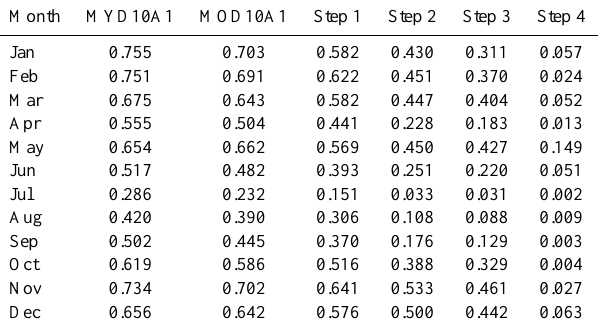
Table 6. Average monthly cloud cover fraction remaining after each step for year